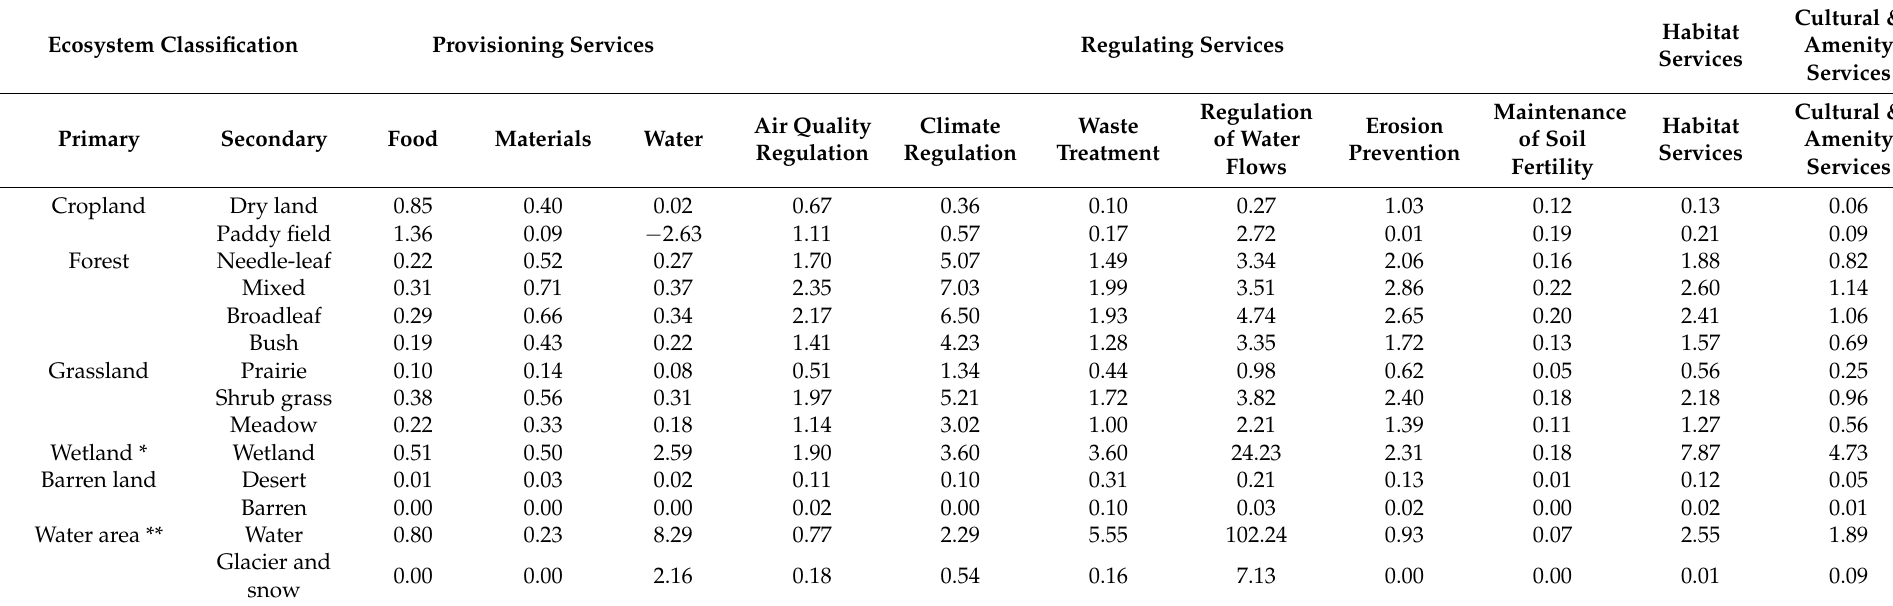
Table 2. The equivalent coefficients table for ecosystem service value (ESV) per unit area for the 6 ecosystems and 4 ecosystem services. [21].